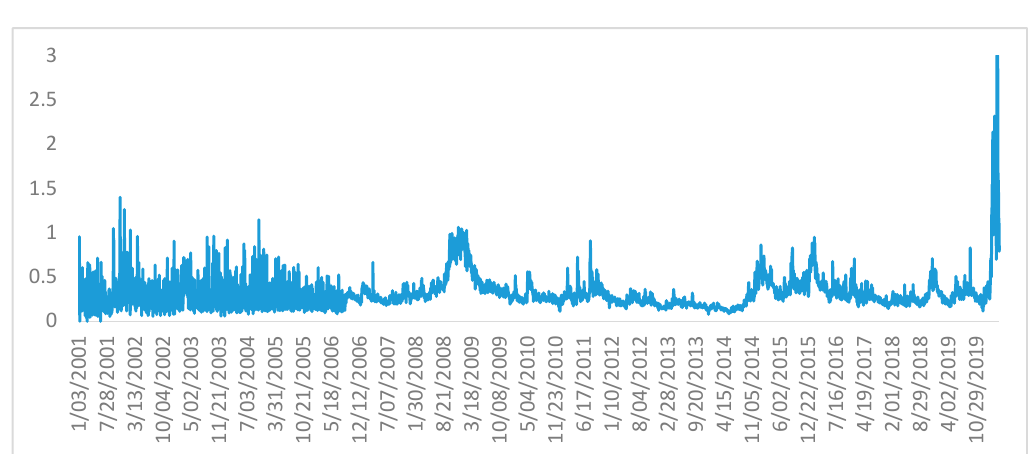
Panel B: Realized volatility (RV)